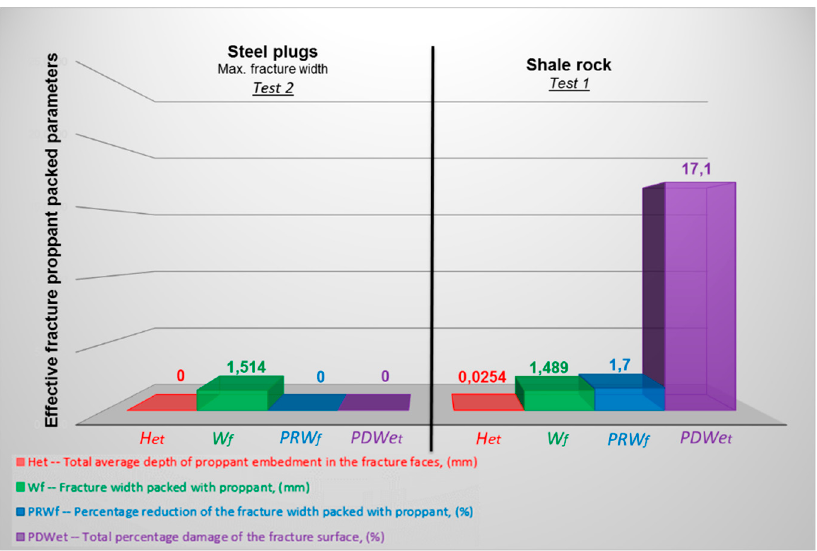
Figure 14. Parameters of the fracture effectively packed with the proppant for cylindrical steel plugs and shale rock.